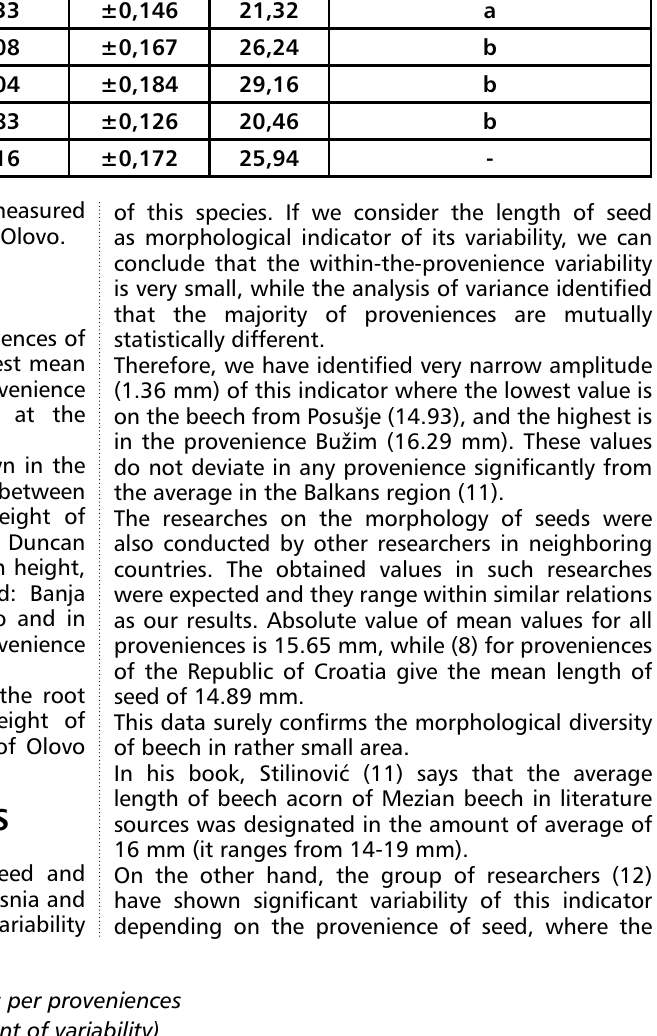
Analysis of the variance of height of saplings per